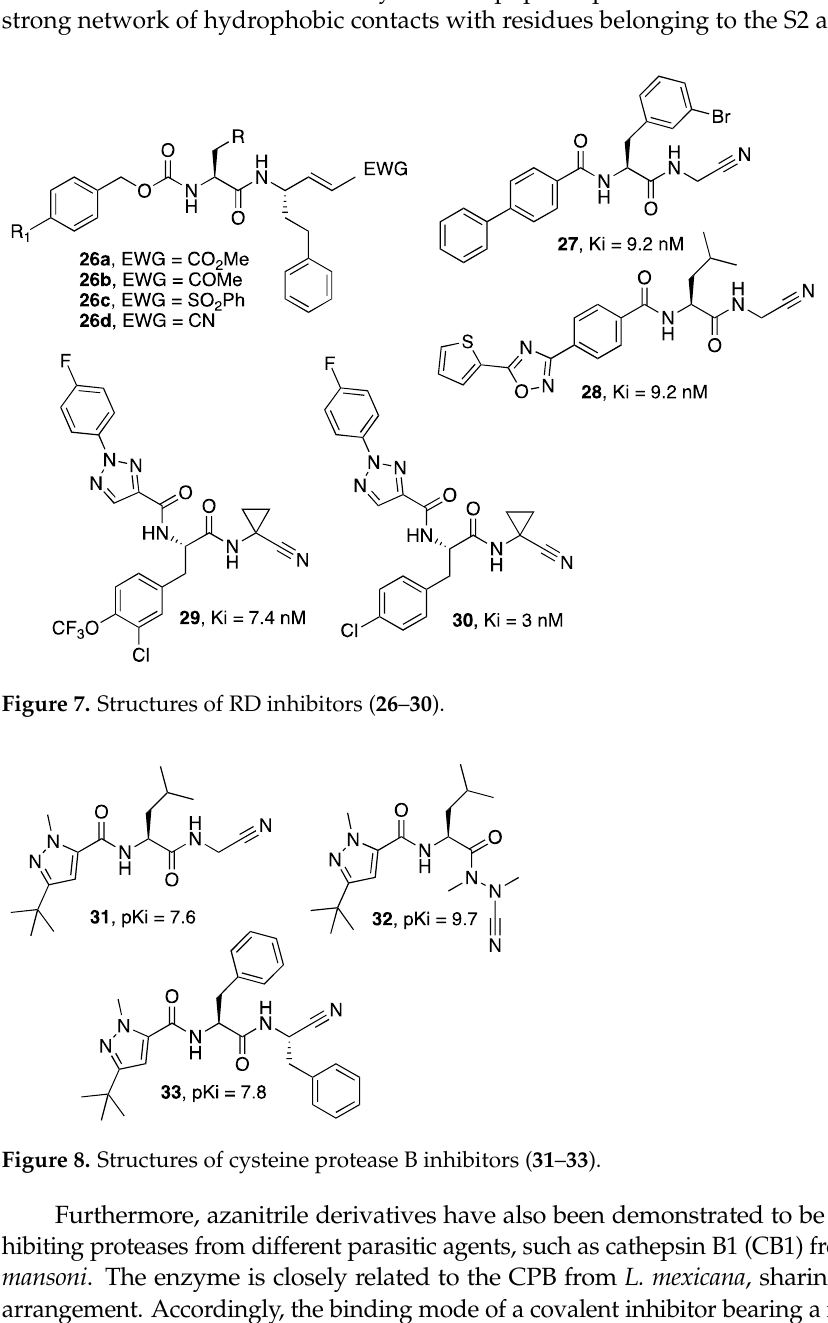
Figure 7. Structures of RD inhibitors ( 26 – 30 ).